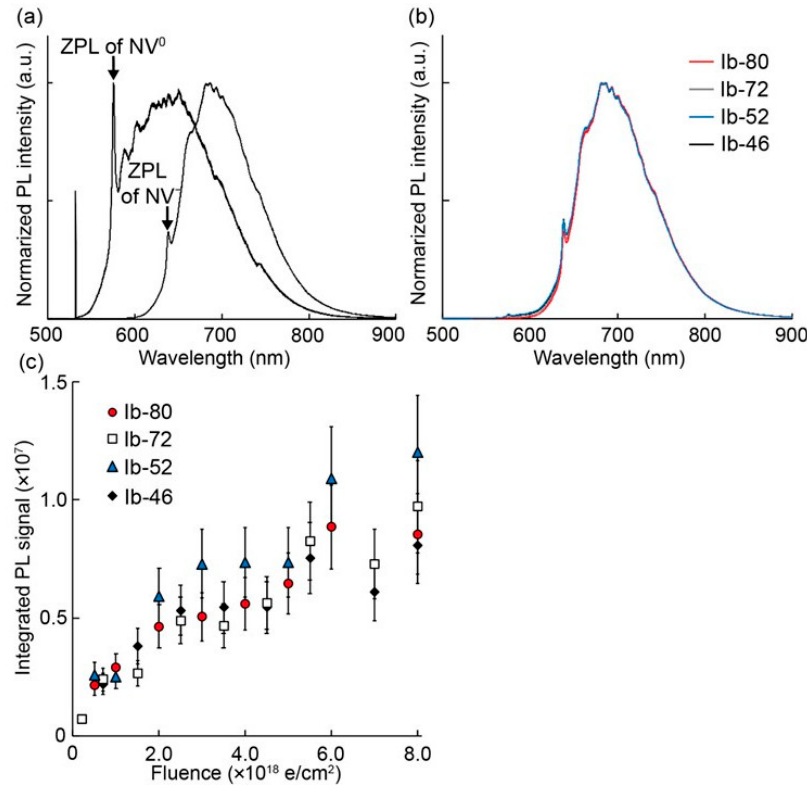
Figure 3. PL measurement of NV − center in type-Ib diamonds after irradiation and subsequent an- nealing. ( a ) Typical PL spectra of NV − and NV 0 center normalized by peak intensity. The typical spectra of NV − and NV 0 center are obtained from Ib-80 and sample contains low P1 center concen- tration (~40 ppb), respectively. The peak at 532 nm is reflected excitation light. The spectra are nor- malized by peak intensity. ( b ) PL spectra at irradiation fluence of 8.0 × 10 18 e/cm 2 for Ib-80 (red line), Ib-72 (gray line), Ib-52 (blue line), Ib-46 (black line), respectively. These spectra are normalized by peak intensity. ( c ) Irradiation fluence dependence of integrated PL intensity for Ib-80 (closed red circles), Ib-72 (open black circles), Ib-52 (closed blue circles), Ib-46 (closed black circle), respectively. NV − centers in triplet ground state can be observed by ESR [13,22]. The typical ESR spectrum of NV − center shows eight peaks caused by zero-field-splitting by spin-spin in- teraction at ground triplet state and four orientations of its electron orbitals due to tetra- hedral symmetry. Figure 4a represents the lefternmost peak of NV − centers where one crystallographic axes, [111], is aligned to the external magnetic field (B 0 ). The spectra clearly show hyperfine splitting by nitrogen nuclear spins. The intensity of spectra obvi- ously increases with increasing irradiation fluence. [NV − ] was calculated and plotted as a function of irradiation fluence in Figure 4b. In contrast to P1 centers, NV − centers increase with increasing irradiation fluence. As a result, 10 ppm of NV − are created in Ib-80 by electron irradiation at the fluence of 8.0 × 10 18 e/cm 2 .